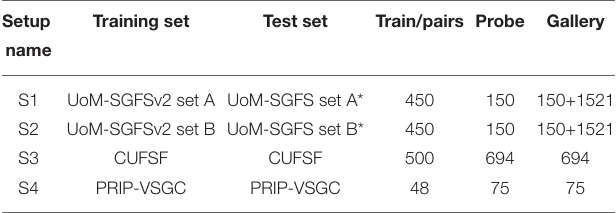
TABLE 1 | Experiment setup, UoM-SGFS set A* is UoM-SGFS set A, MEDS -II, FEI, and LFW, and UoM-SGFS set B* is UoM-SGFS set B, MEDS -II, FEI, and LFW.